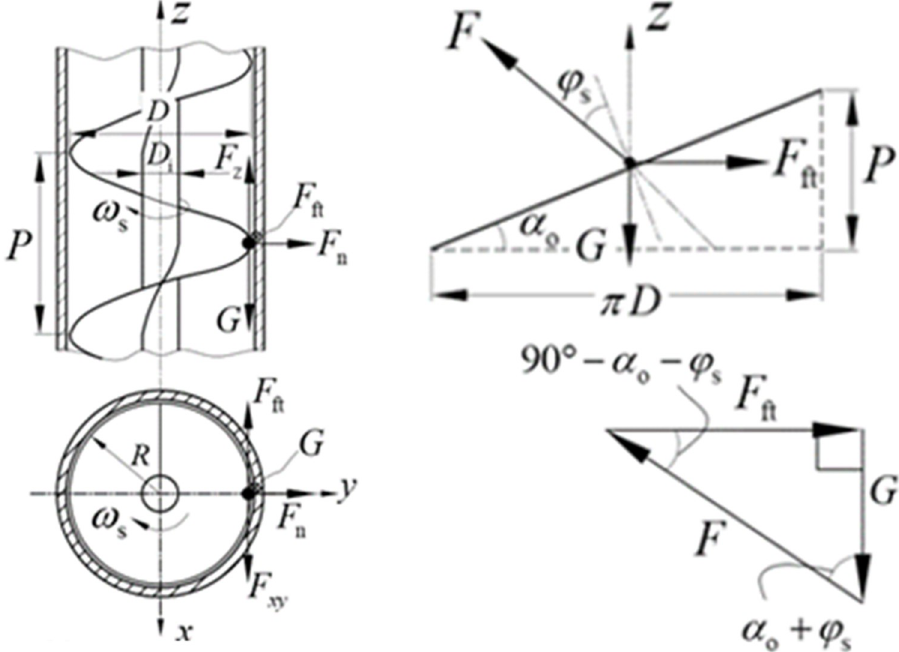
Fig 3. Mechanical analysis of particles. (A) Particle force diagram. (B) Axial direction. (C) Radial direction.